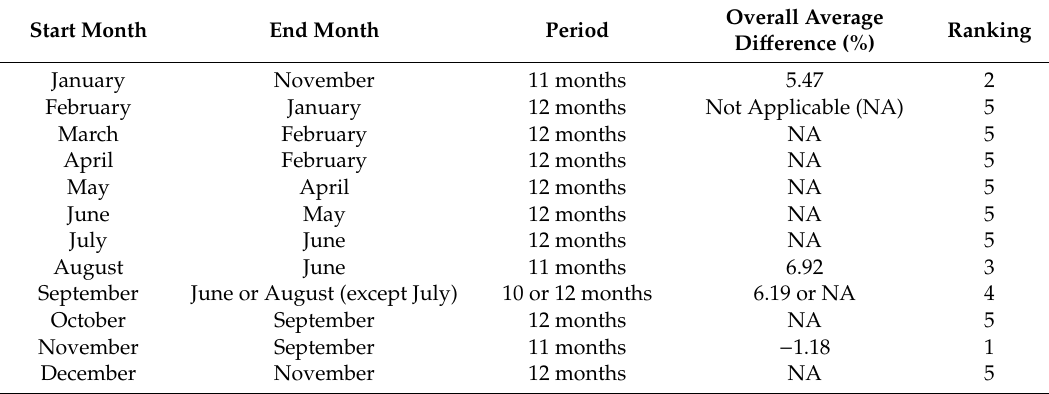
Table 7. Results from the ranking analysis for all the three coe ffi